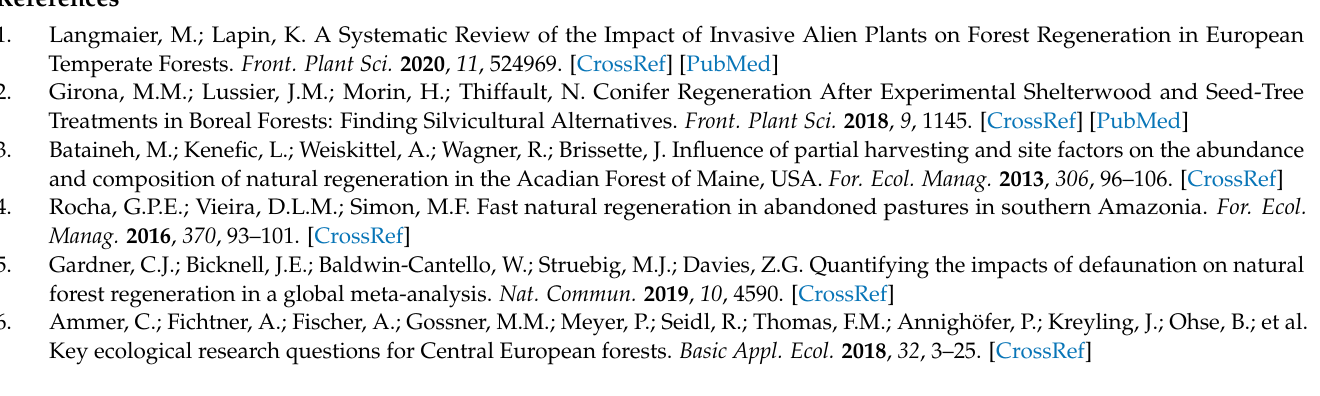
Table S2. Soil bacterial community co-occurrence network characteristics with different regeneration degrees. Table S3. Topological properties of potential functional co-occurrence networks of soil bacterial communities with different regeneration degrees. Table S4. Percent variance explained of the degree of regeneration by each environmental factor. Table S5. Correlation analysis of several environmental factors with regeneration. Table S7. Correlation analysis of soil bacterial communities at phyla levels with regeneration. Table S8. SEM model fit indices for all factors. Table S9. Indirect, direct, and total effects between the observed variables in the SEM (standardized